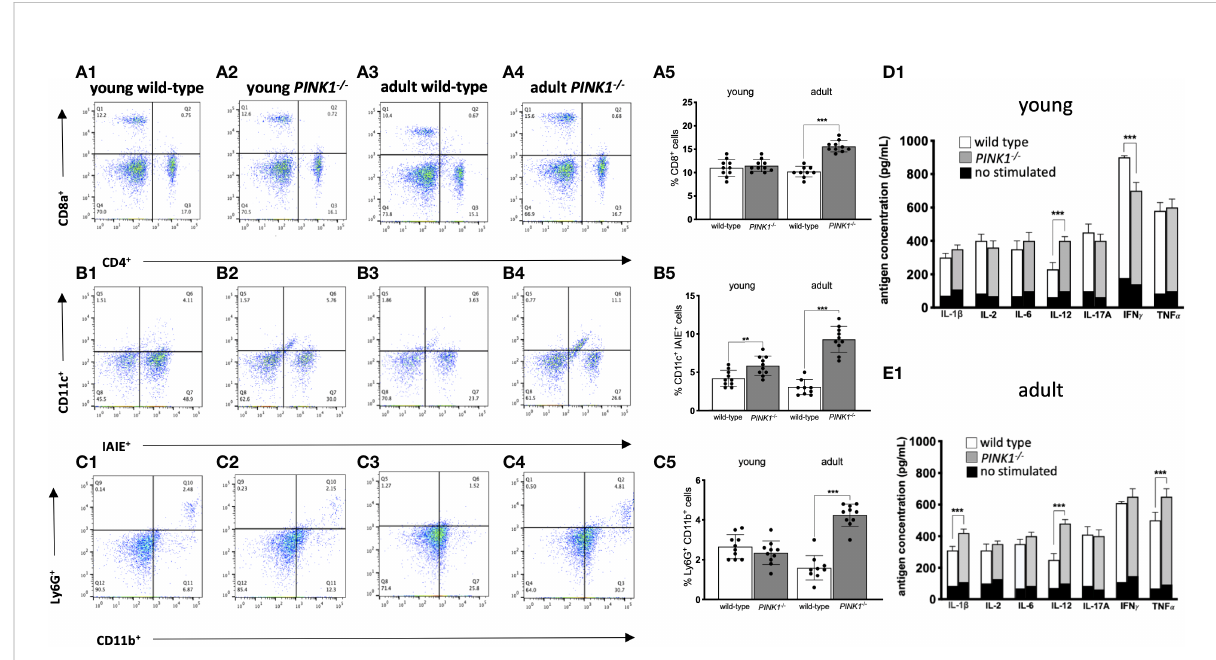
FIGURE 3 Immune cell populations and cytokine pro fi les in splenocytes during the acute phase. (A1 – A5) Representative blots showing CD4 + and CD8 + T lymphocytes and its representative graph. (B1 – B5) Representative blots showing conventional dendritic cells and its representative graph. (C1 – C5) Representative blots showing different myeloid cells and its representative graph. Cytokine expression pro fi les in culture supernatants of MOG 35-55 -stimulated spleen cell (D1, E1) . The data show one experiment (N =10 mice/group) of three independent ones. Data are expressed as mean ± SD calculated using Student ’ s t-test * p < 0.0, ** p < 0.01, *** p <